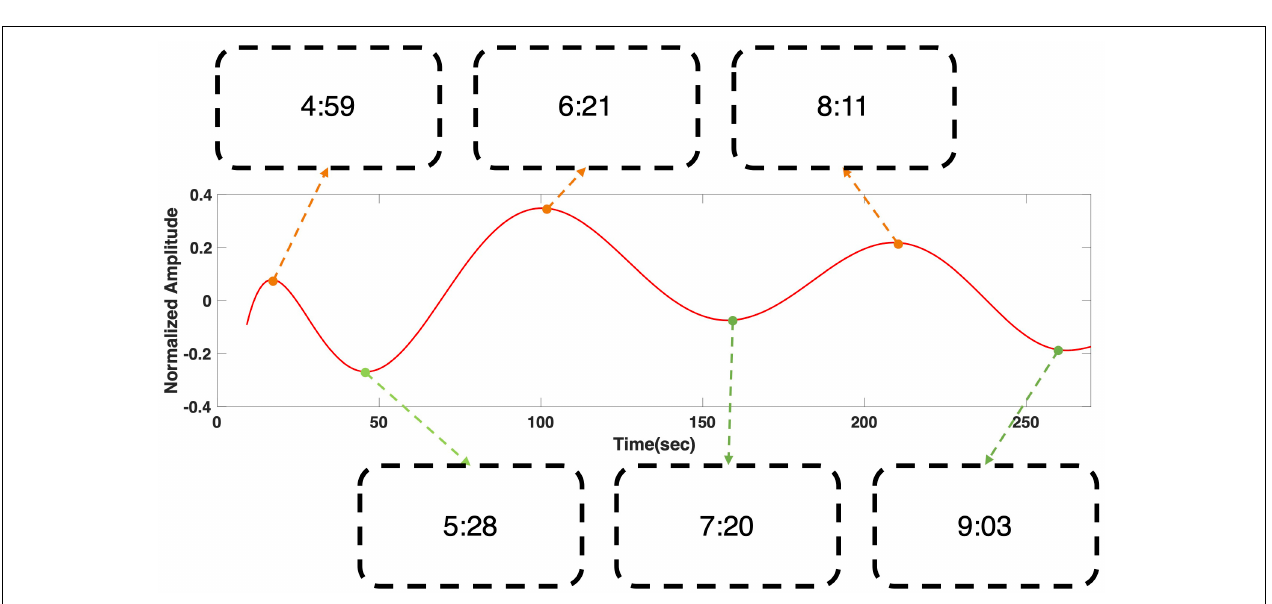
FIGURE 4 | Grand averaged polynomial regression result of SSVEP response at 6 Hz during “fear” movie screening. The minima corresponded with relatively ordinary scenes, while the maxima corresponded to the scenes with appearance of specter. The scenes corresponding to each local extrema can be found using the time stamps in the boxes. The time stamps correspond to the time points in the following movie clip: https://youtu.be/xeqwAVO0UFg.